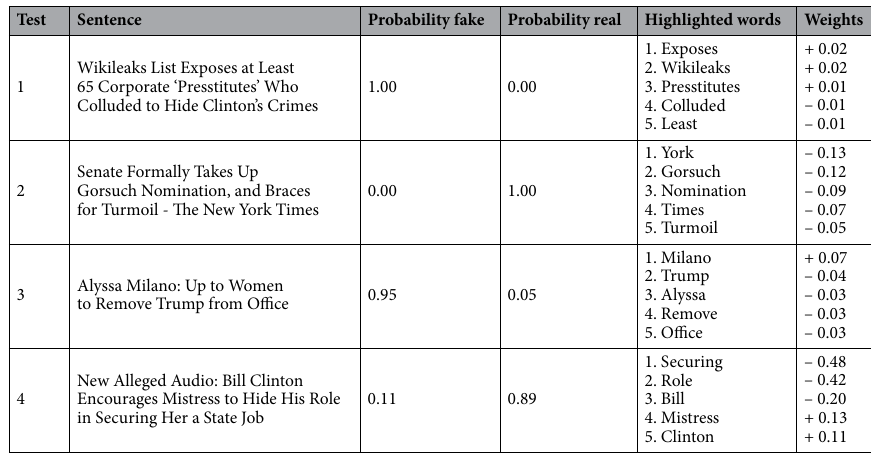
Table 4. LIME explanations for the four test scenarios - Bidirectional LSTM